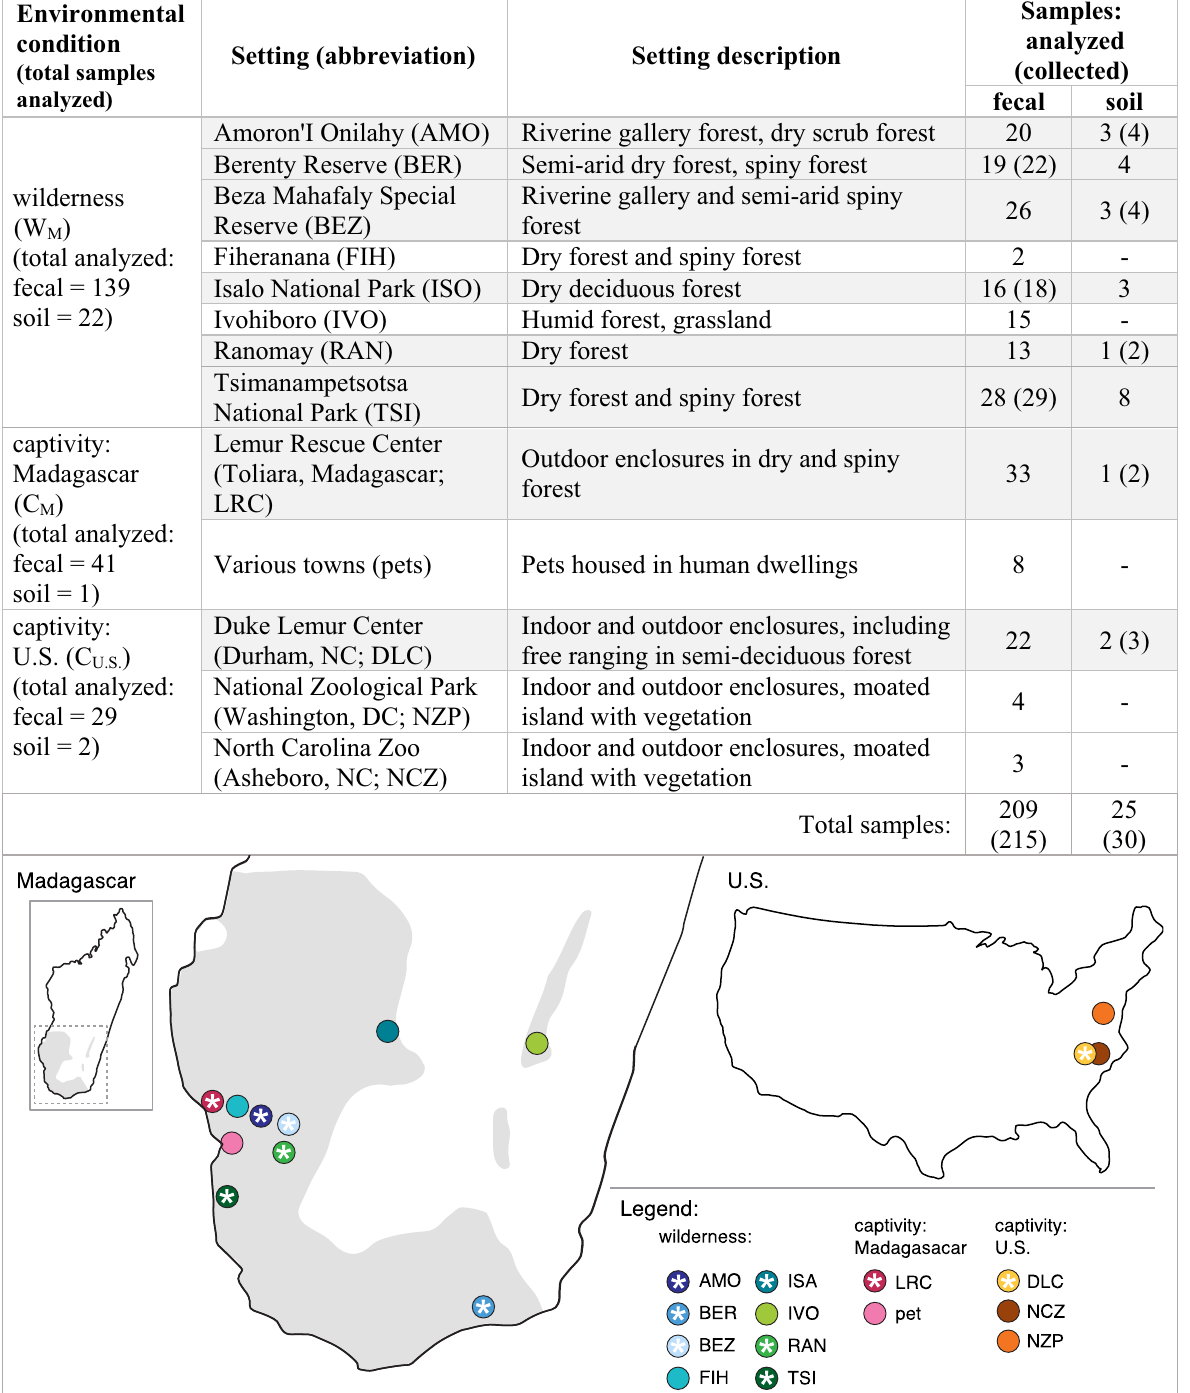
Table 1 Research settings (names, descriptions, and locations) and samples collected under wilderness conditions and under captivity conditions in Madagascar and the